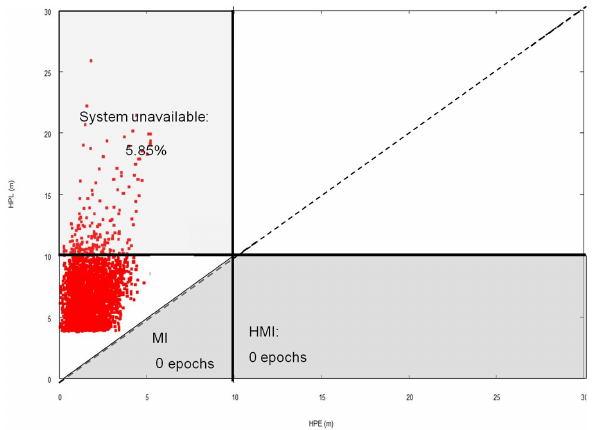
Figure 5: Stanford diagram comparing the true error and the pro- tection level on the horizontal subspace.